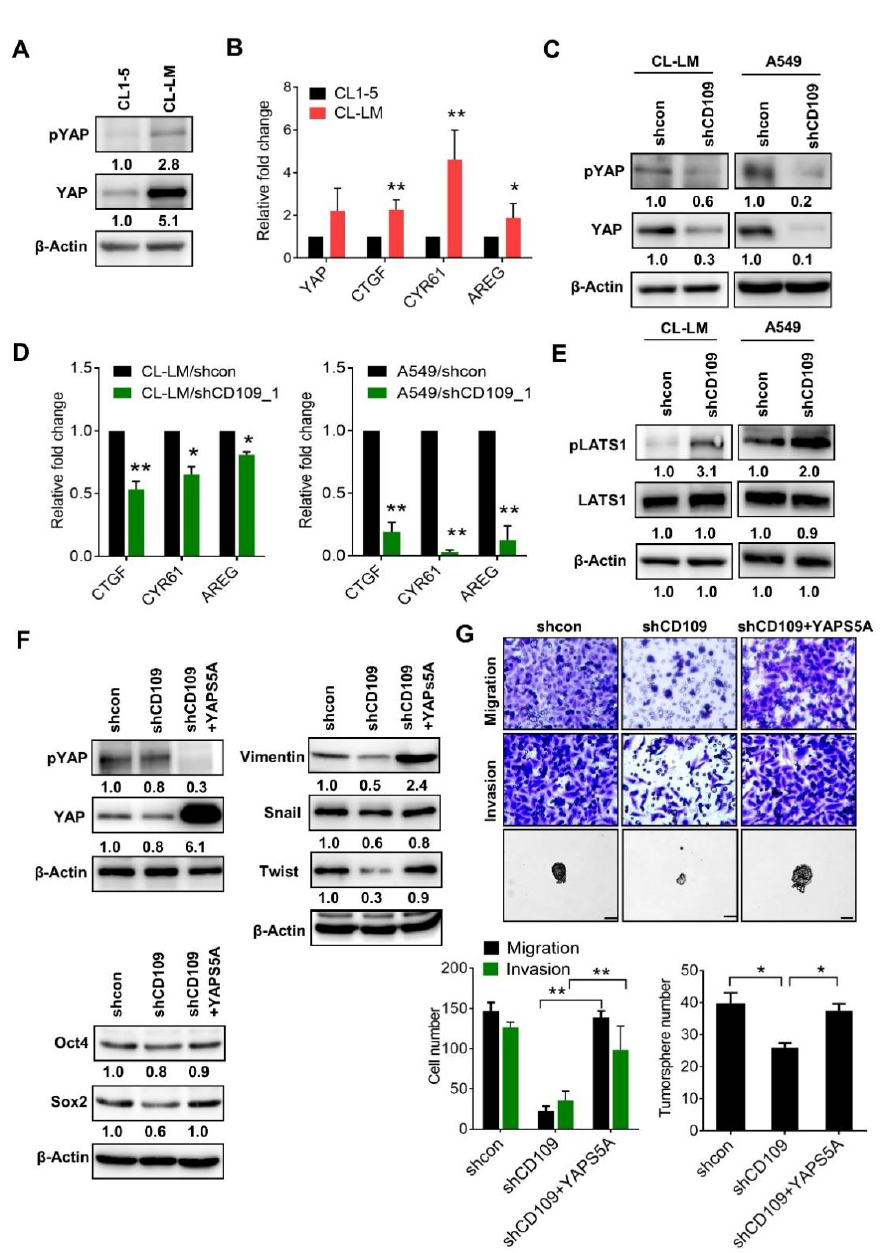
Figure 5. Expression of CD109 regulates YAP. ( A ) Western blot analysis of YAP and phosphorylated YAP protein levels in CL1-5 and CL-LM cells. Quantitative analyses were performed using Image J software. ( B ) Real-time PCR analysis of YAP and YAP downstream gene expressions in CL1-5 and CL-LM cells. ( C ) Western blot analysis of YAP and phosphorylated YAP protein levels in CD109-silenced A549 and CL-LM cells. ( D ) Real-time PCR analysis of YAP downstream gene expressions in CD109-silenced A549 and CL-LM cells. ( E ) Western blot analysis of phosphorylated LATS1 protein level in CD109-silenced A549 and CL-LM cells. ( F ) Western blot analysis of EMT- and stemness- related protein levels in A549/sh-control, shCD109, and shCD109+YAPS5A cells. ( G ) Representative images of tumor migration, invasion, and tumorsphere formation in A549/sh-control, shCD109, and shCD109+YAPS5A cells. Data were derived from three random fields by three independent experiments, and results are expressed as the mean ± SD. Quantification of protein bands from Western blot was carried out by Image J software. * p < 0.05; ** p < 0.01, as determined by an unpaired t -test. Scale bar, 50 µ